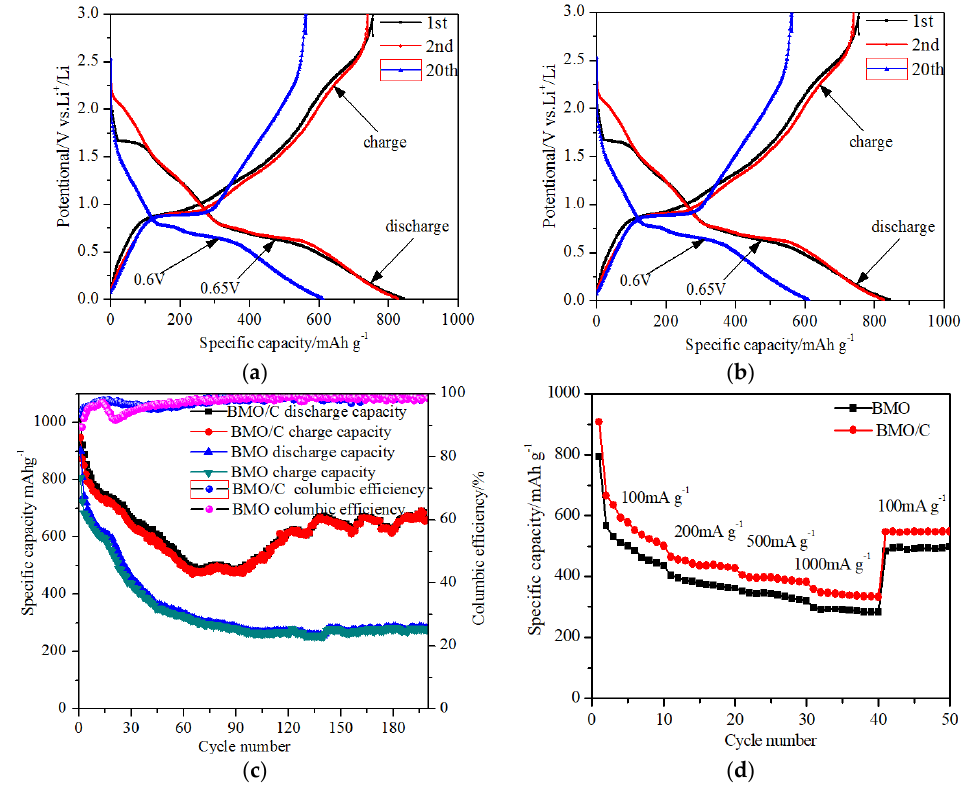
Figure 6. Discharge and charge curves of ( a ) BMO, ( b ) BMO/C electrodes for the 1st, 2nd and 20th cycle at a constant current density 100 mA·g − 1 , and ( c ) cycling performance and the corresponding columbic efficiency of BMO and BMO/C electrodes at current density of 100 mA·g − 1 , ( d ) discharge and charge rate performance of BMO and BMO/C electrodes at current densities of 100, 200, 500, 1000 and 100 mA·g − 1 .